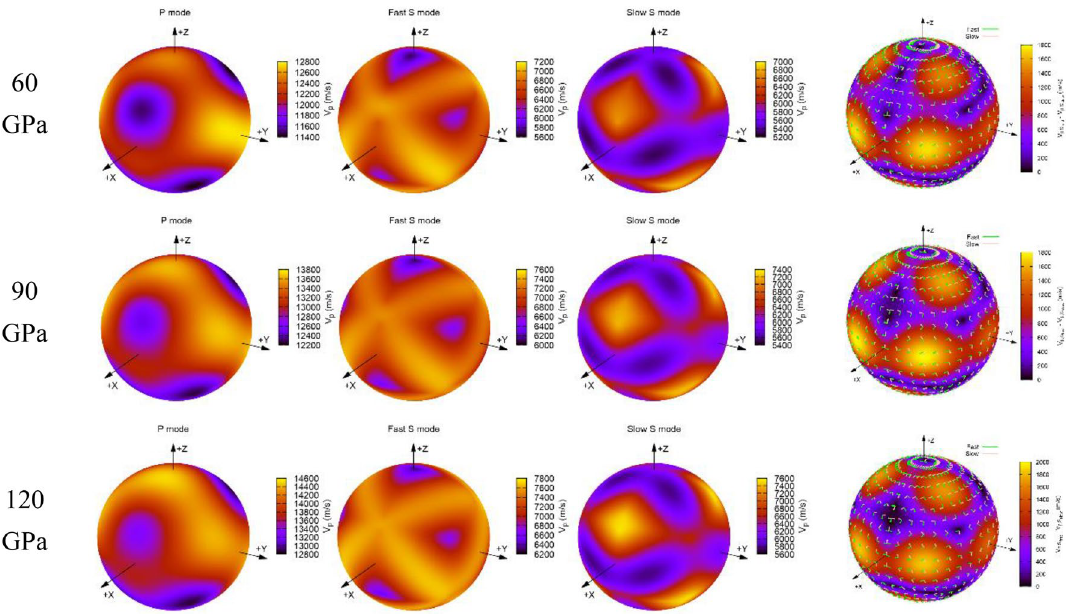
Figure 9. 3D representation of the V P and V S and the shear wave splitting and polarization vectors of MgCO 3 - C 2 /m at various